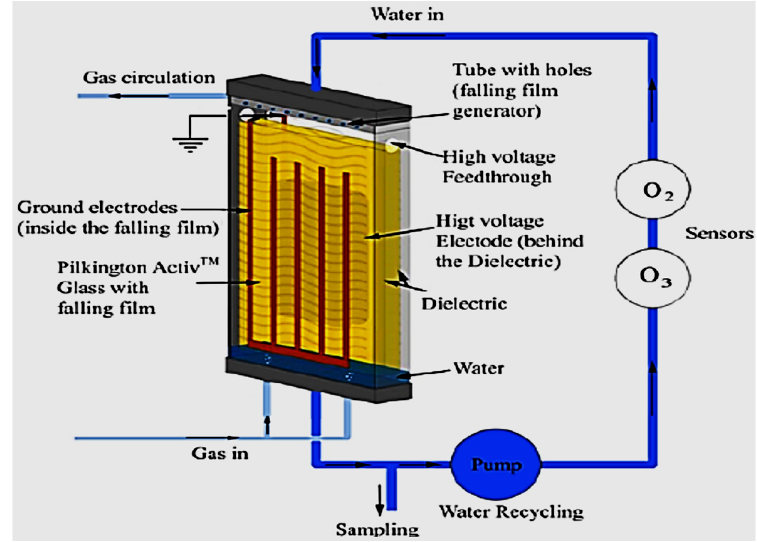
Figure 10. Planar water falling dielectric barrier discharge (DBD) reactor used for the degradation of diclofenac (DCF) and ibuprofen (IBP) pharmaceuticals [165].